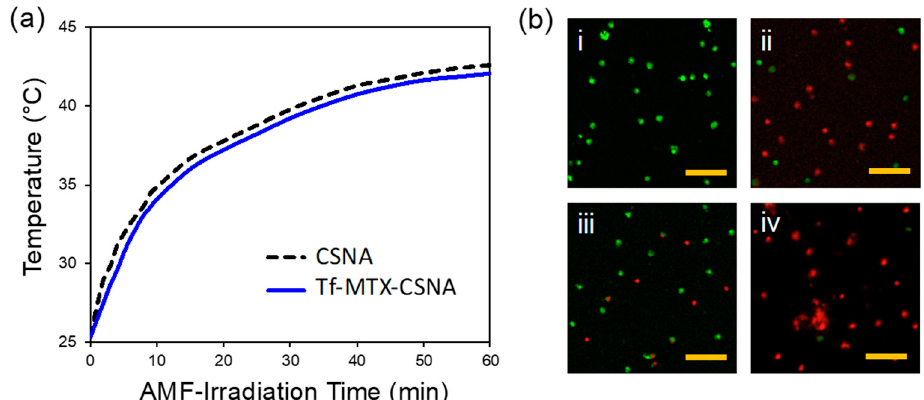
Figure 8. Magneto-thermal activity of the CSNA samples. ( a ) Plot of the temperature increase by AMF-irradiation. The Tf-MTX-CSNAs show similar magneto-thermal activity to bare CSNAs, confirming their outstanding magnetic stability after the conjugation processes. ( b ) Fluorescence images of Hela cells in the presence of the CSNA (i, ii) and Tf-MTX-CSNA (iii, iv) samples, before (i, iii) and after (ii, iv) the AMF-treatments (scale bar: 100 µm).